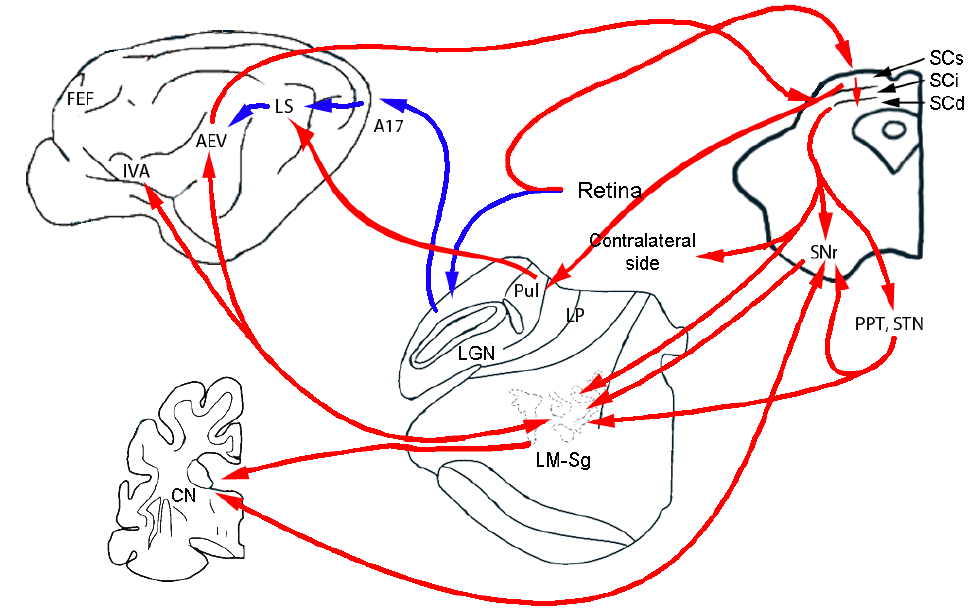
geniculo-cortical (primary) visual pathway (blue arrows) and the ascending tectofugal visual pathway (red arrows) in the cat‘s brain. Abbreviations: LGN—Lateral geniculate nucleus, Pul—Pulvinar, LP—Lateral-posterior nucleus of the thalamus, A17—Visual area 17 (primary visual cortex), LS—Lateral suprasylvian cortex, AEV—anterior ectosylvian visual area, IVA—Insular visual area, LM-Sg—Lateral medial-suprageniculate nuclei of the thalamus, SNr—Substantia nigra pars reticulata, PPT—Pedunculo-pontin tegmental nuclei, STN—Subthalamic nucleus, SCs, SCi, SCd—Superior colliculus (superficial, intermedier, deep layers, respectively), CN—Caudate nucleus, FEF—Frontal eye